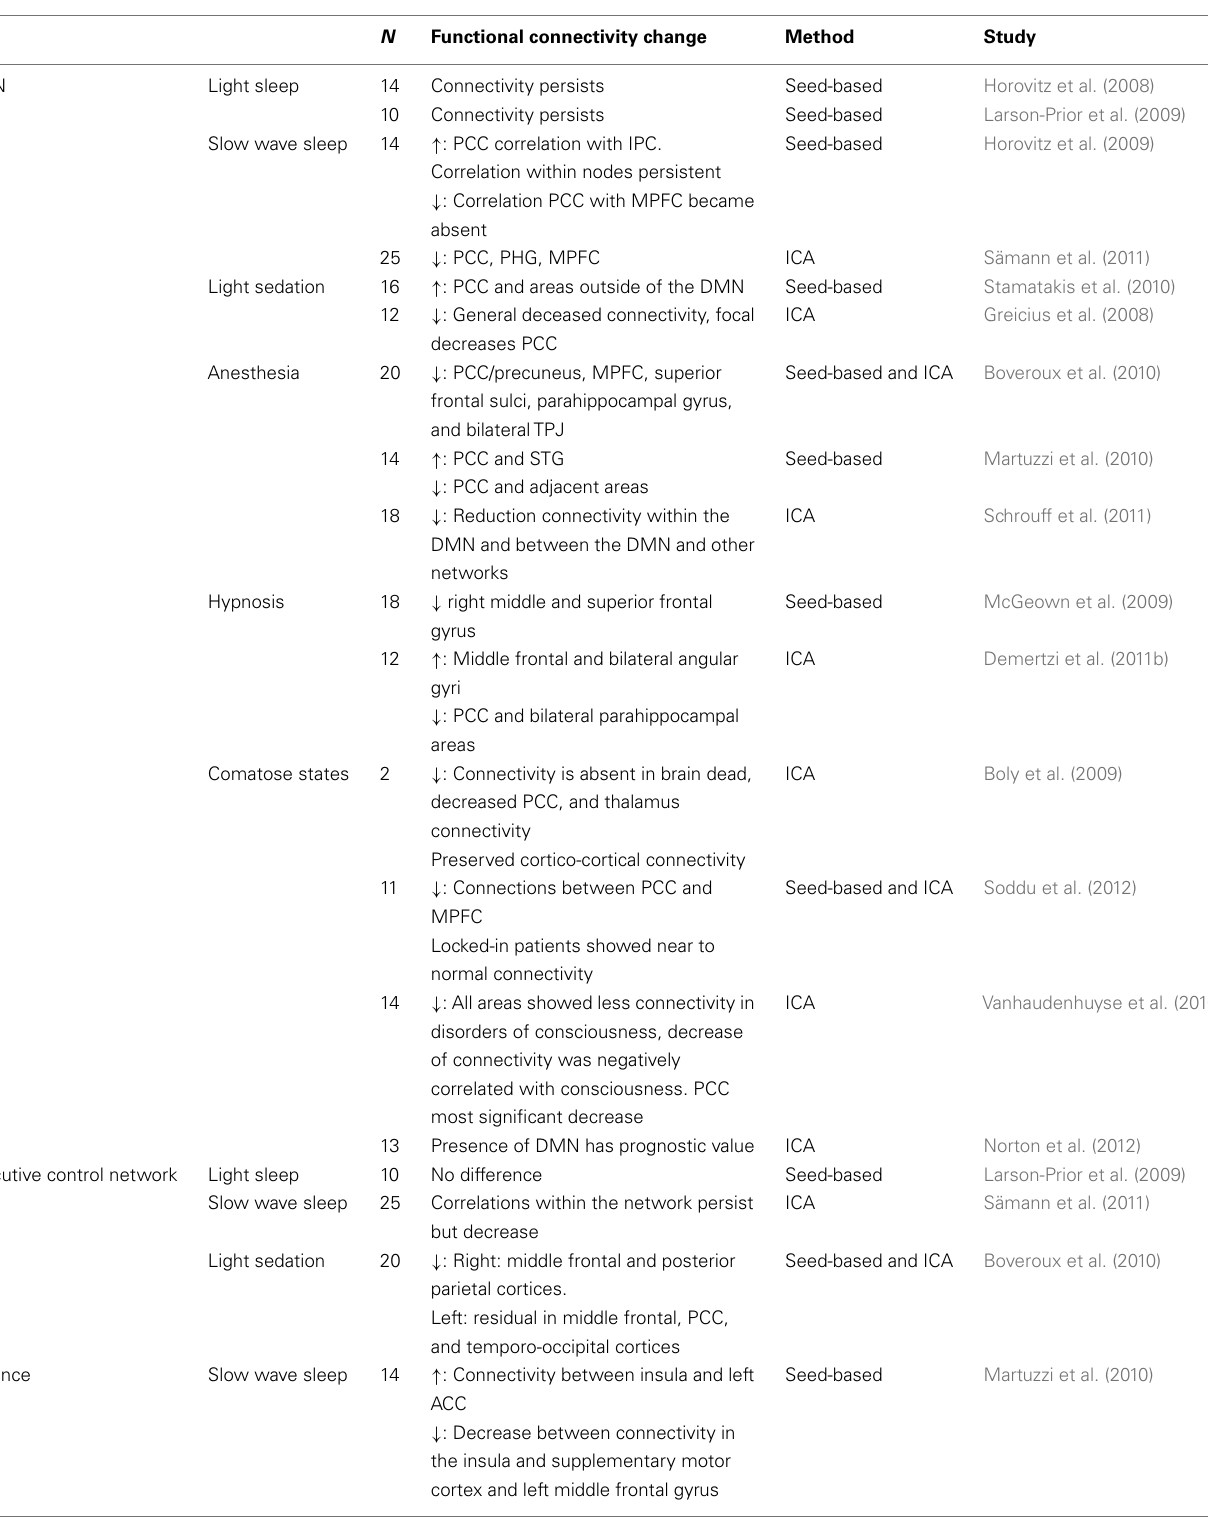
Table 1 | FMRI studies showing alterations in resting state functional connectivity of multiple networks in physiological (sleep, hypnosis), pharmacological (sedation), and pathological states of